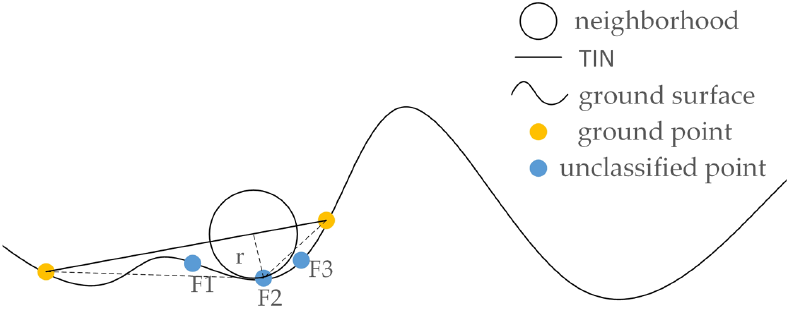
Figure 4. Determination of the misclassified ground